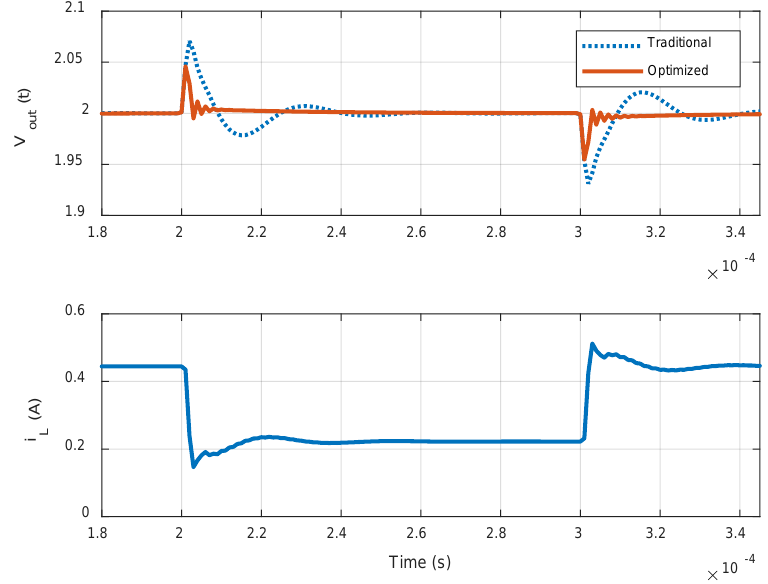
Figure 15. Response of the controllers against the changes in load current.